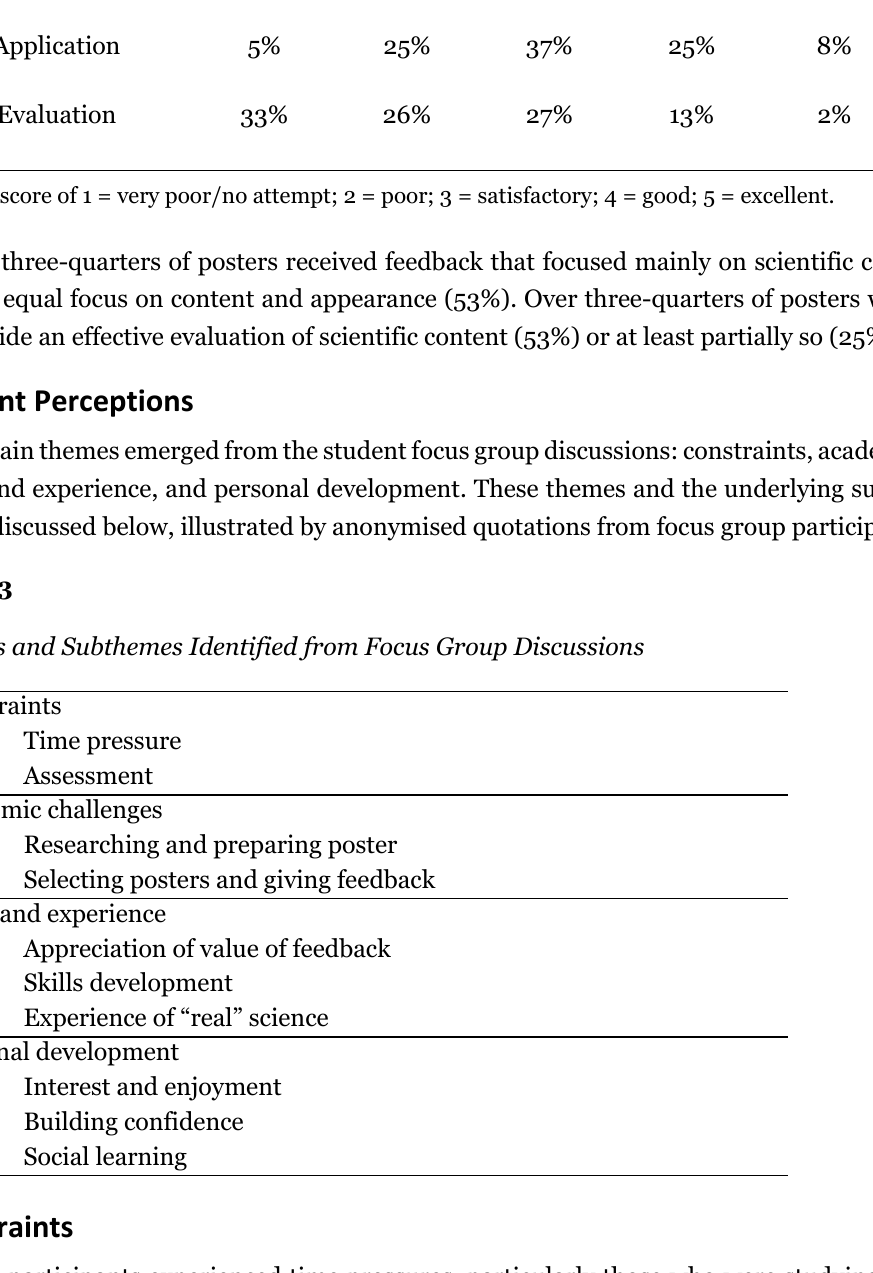
Percentage of Scores Awarded and Mean Likert Score for the Overarching Criteria Overarching criterion Score 1 2 Mean Understanding